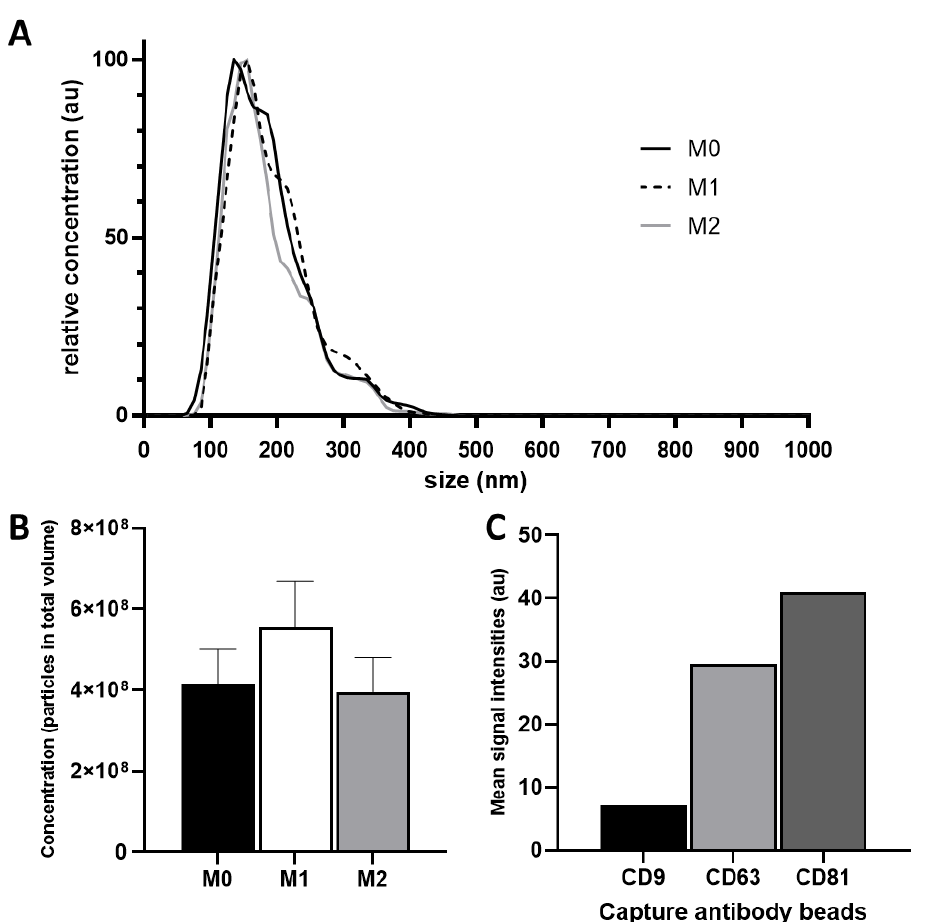
Figure 1. ( A ) Relative size distribution analysis of EV preparations. Three EV samples derived of differently polarized macrophages were isolated and prepared individually via TFF and assessed using NanoSight LM14 analyzer; ( B ) Mean particle concentrations of M0, M1 and M2; ( C ) Flow cytometry analysis of tetraspanin markers CD9, CD63, and CD81 on isolated EVs.